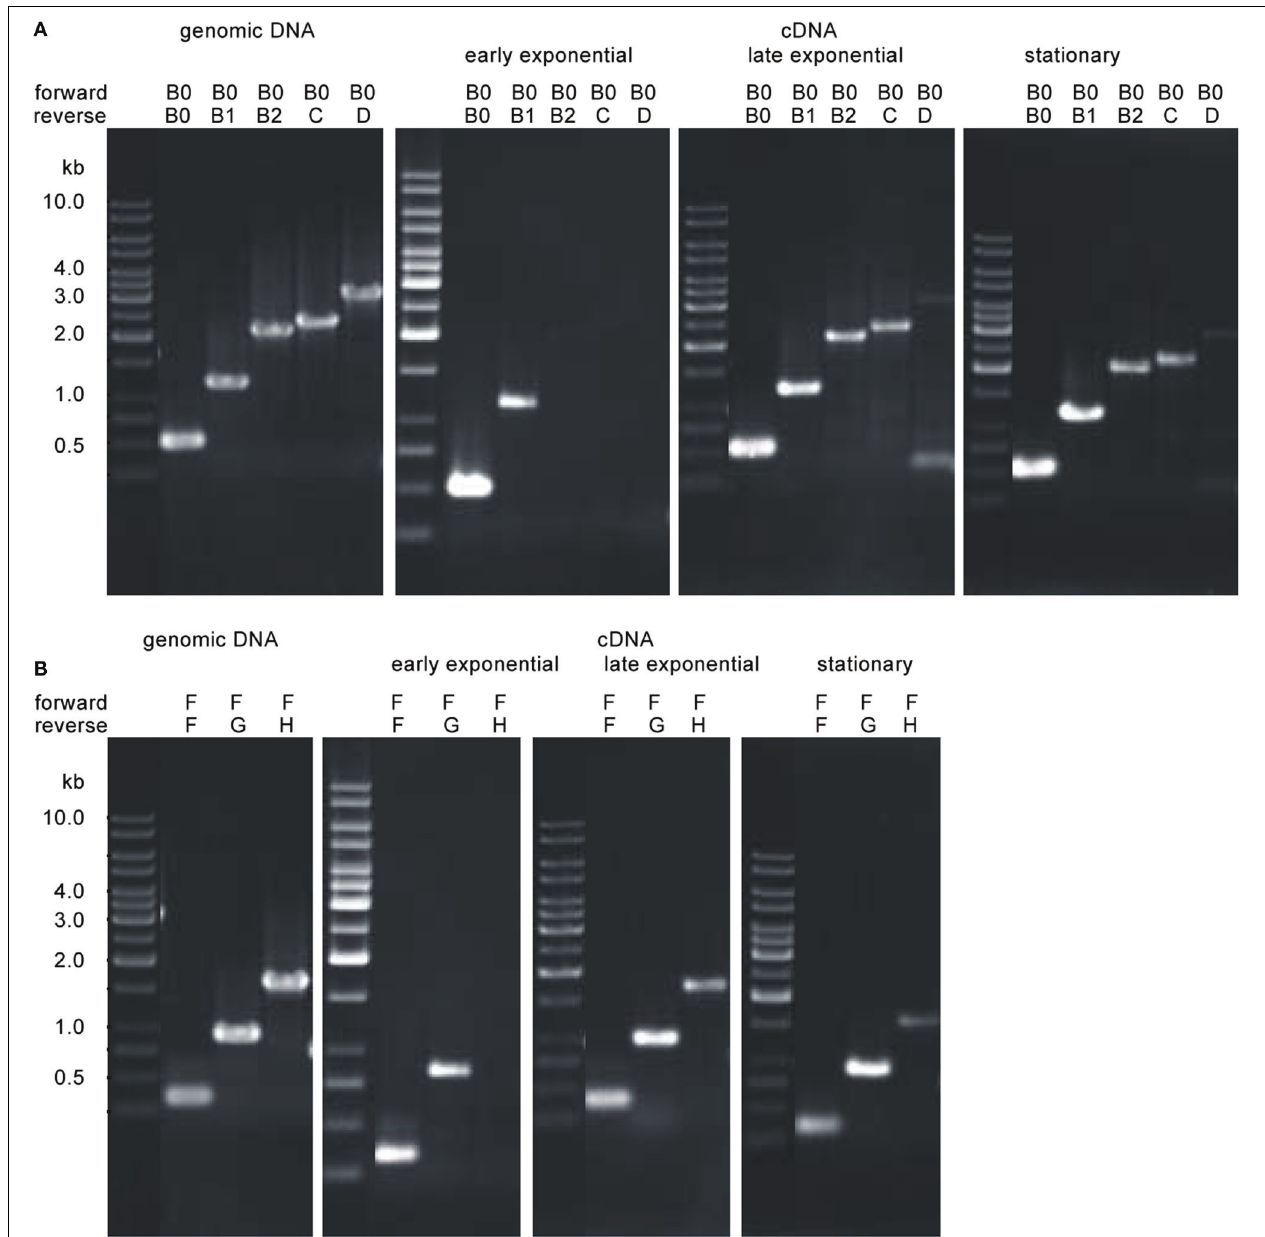
FIGURE 7 | Transcriptional analyses of the P. furiosus flagellar operon depending on the growth phase. Total RNA was isolated from cells of early exponential growth phase ( ∼ 1 × 10 7 cells/ml; panel 2), late exponential growth phase (4–5 × 10 7 cells/ml; panel 3) and stationary growth phase ( ∼ 2 × 10 8 cells/ml; panel 4) and transcribed into cDNA; transcripts were amplified by PCR using different sets of primers. PCR